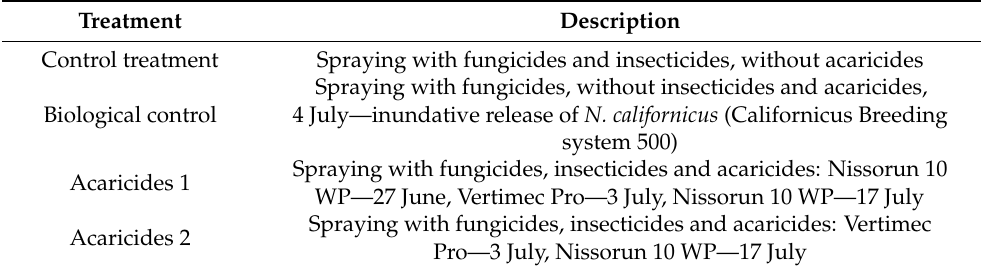
Table 1. Detailed description of treatments used in our survey. Treatment Description Control